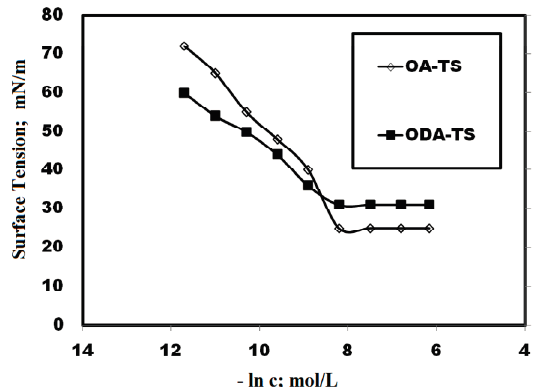
Figure 4. Adsorption isotherms of OA-TS and ODA-TS at temperature of 25 °C.